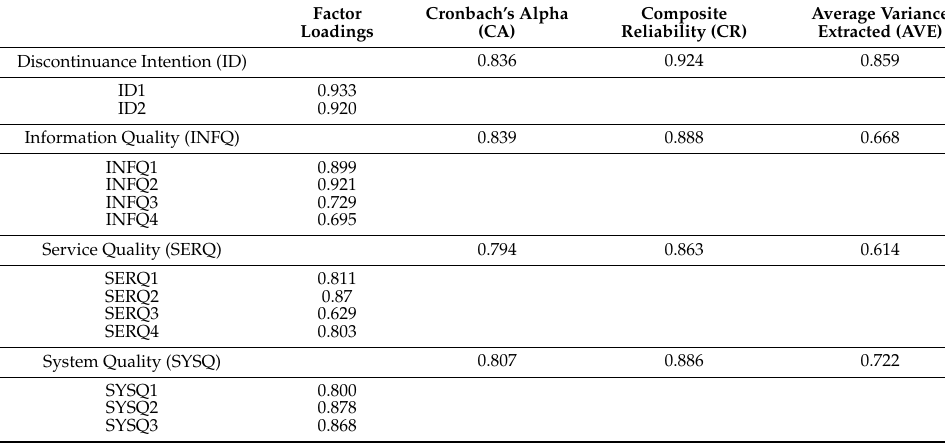
Table 1. Measurement model